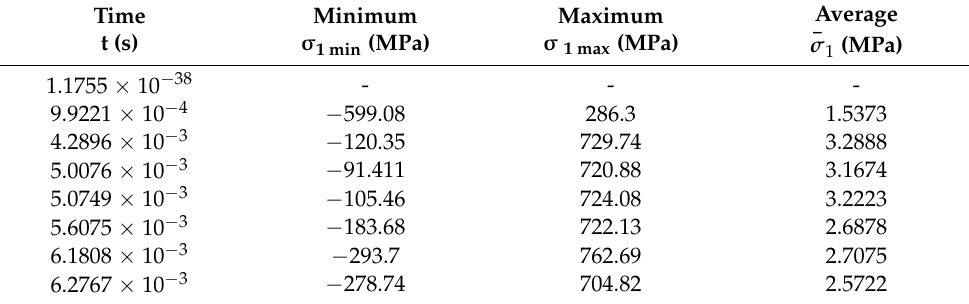
Table 8. Maximum principal